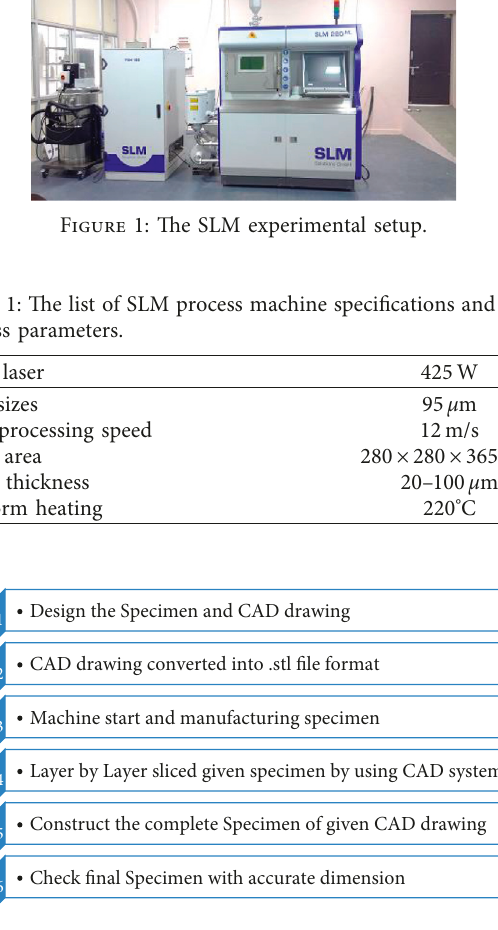
Figure 2: Working of selective laser melting (SLM)